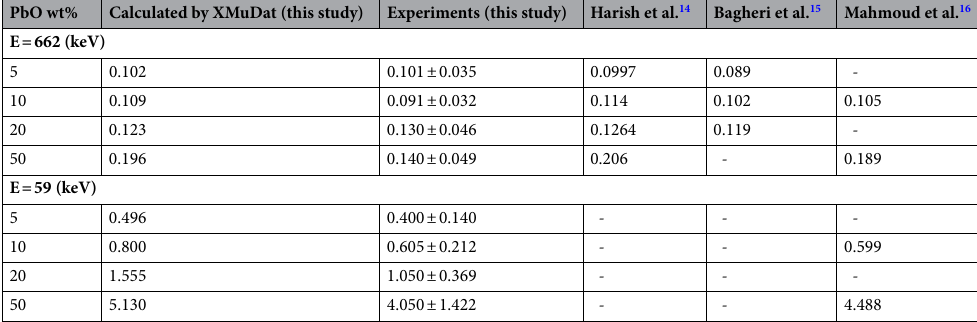
Table 2. The linear attenuation coefficients obtained in the present study using the computational and experimental methods compared to the results of similar studies.